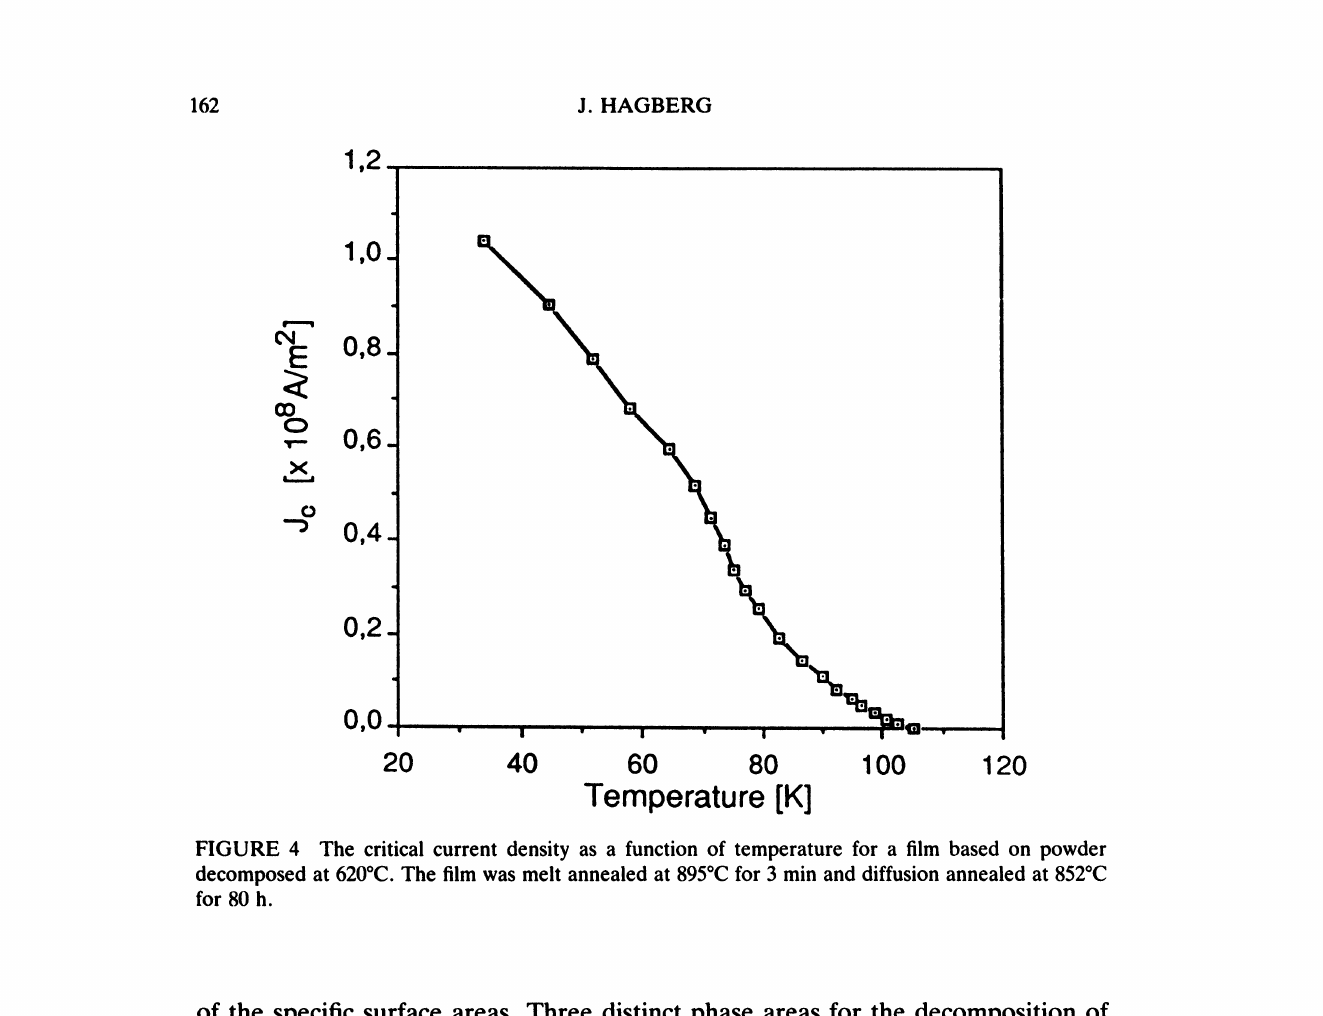
FIGURE 4 The critical current density as a function of temperature for a film based on powder decomposed at 620C. The film was melt annealed at 895C for 3 min and diffusion annealed at 852C for 80